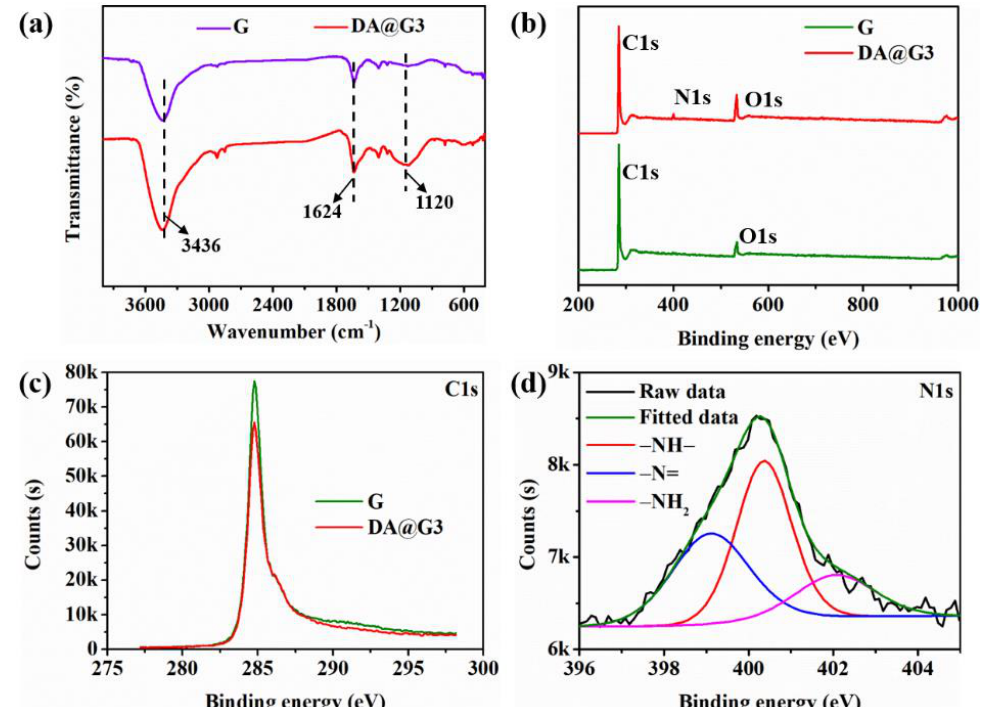
Figure 2. FTIR and XPS spectra for G and DA@G3 powder: ( a ) FTIR spectra, ( b ) XPS survey scan, ( c ) high resolution scans for C1s, and ( d ) high-resolution scans for N1s.